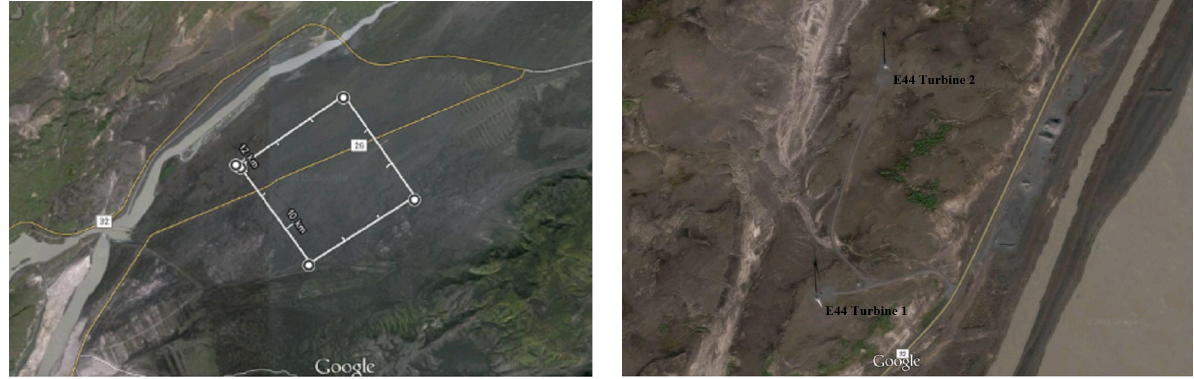
Figure 5. The space available at the Búrfell site is shown on the left and the layout of the E44 test turbines on the right [67].